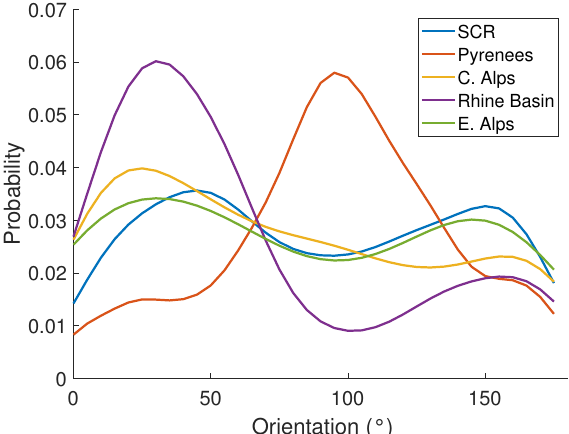
Figure A1. Pdf of orientation obtained from fault map for each SHARE region. C. and E. Alps respectively stand for Compressional and Extensional Alps (regions 4 and 6 Figure 4). No fault is localized in the oceanic crust region in the data we used thus this region isn’t associated to pdf of orientation.